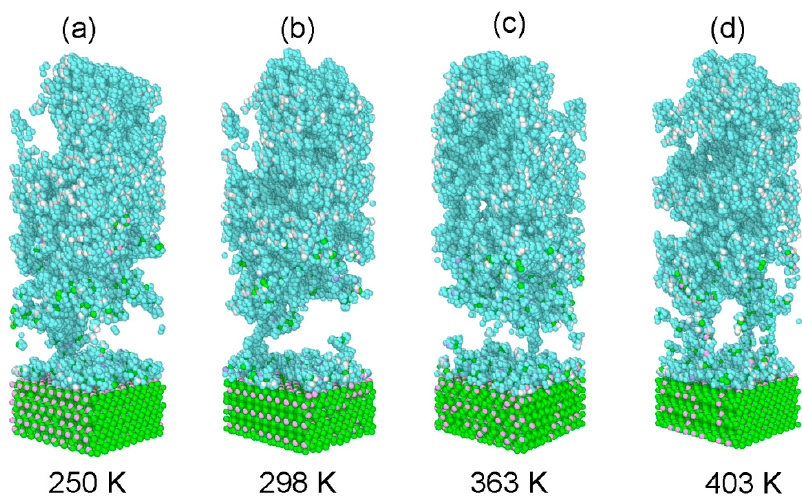
Figure 14. Snapshots of the deformation of the glass fiber/PP material system at the final strain of 100% at various loading temperatures with the strain rate of 2 × 10 11 s − 1 .